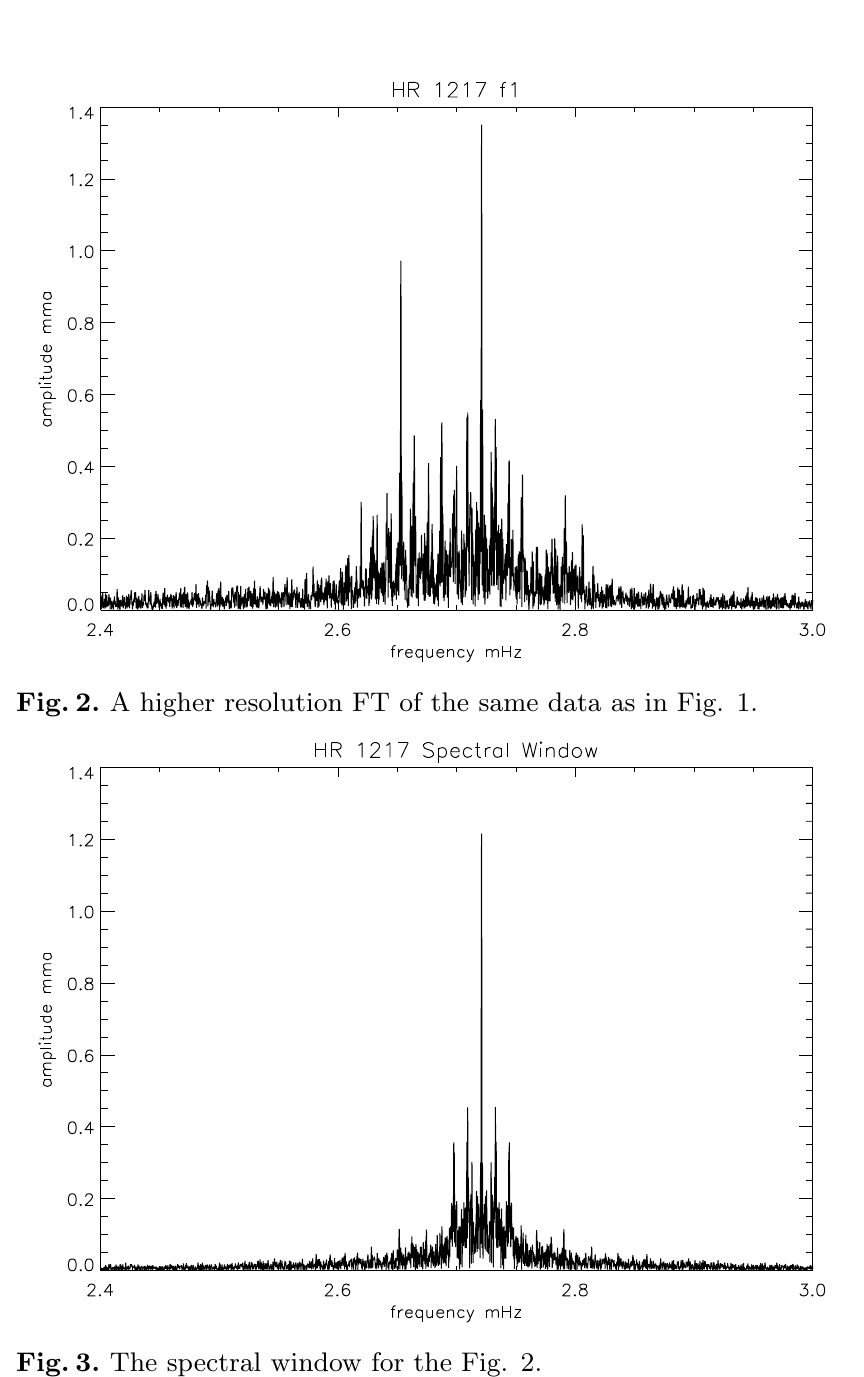
Fig. 3. The spectral window for the Fig.